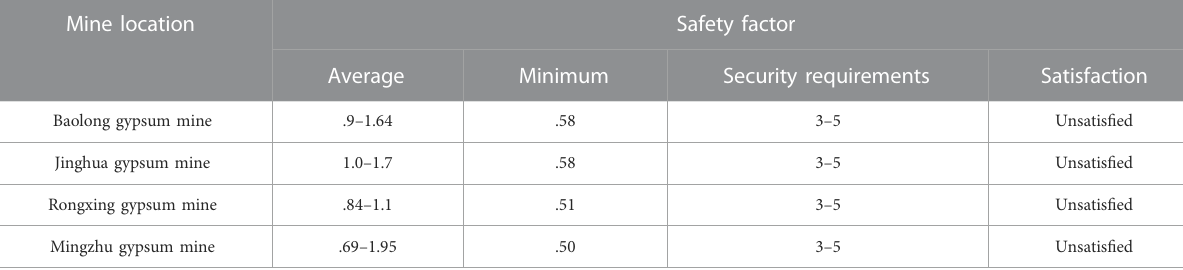
TABLE 7 Safety factor of mine column stability.